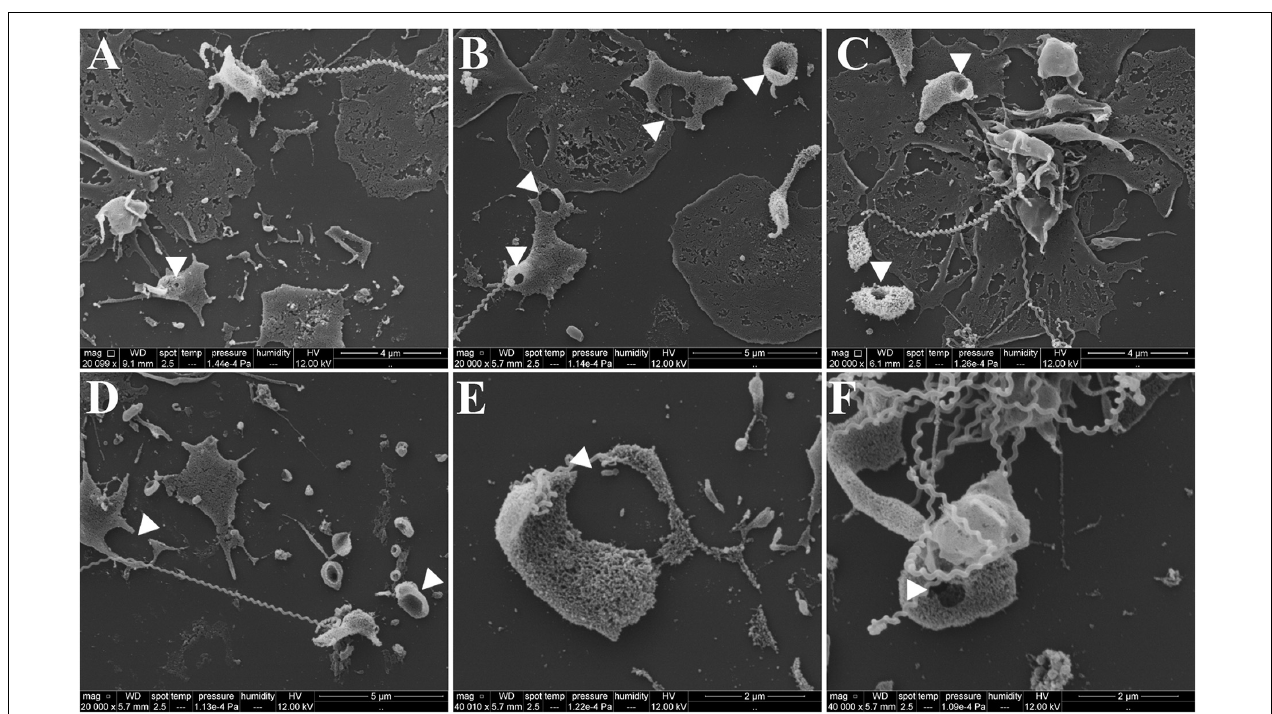
FIGURE 4 | SEM showing platelet fragmentation and disruption after treatment with virulent leptospires. Pre-adhered washed platelets were incubated with virulent L. interrogans , resulting in platelet detachment, membrane disruption and fragmentation. Bacteria are seen interacting directly with the cells. The white arrowheads point to platelet perforations occurring at different levels. (A–D) 20,000 magnification. (E,F) 50,000 magnification. The figure shows representative panels of the samples. Two independent experiments were performed, with similar